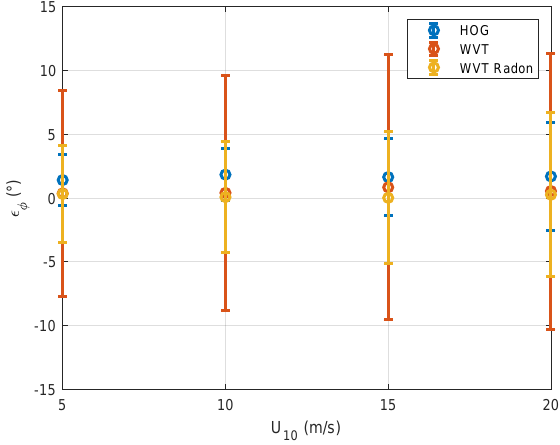
Figure 11. Error mean and standard deviation in function of wind speed for various direction